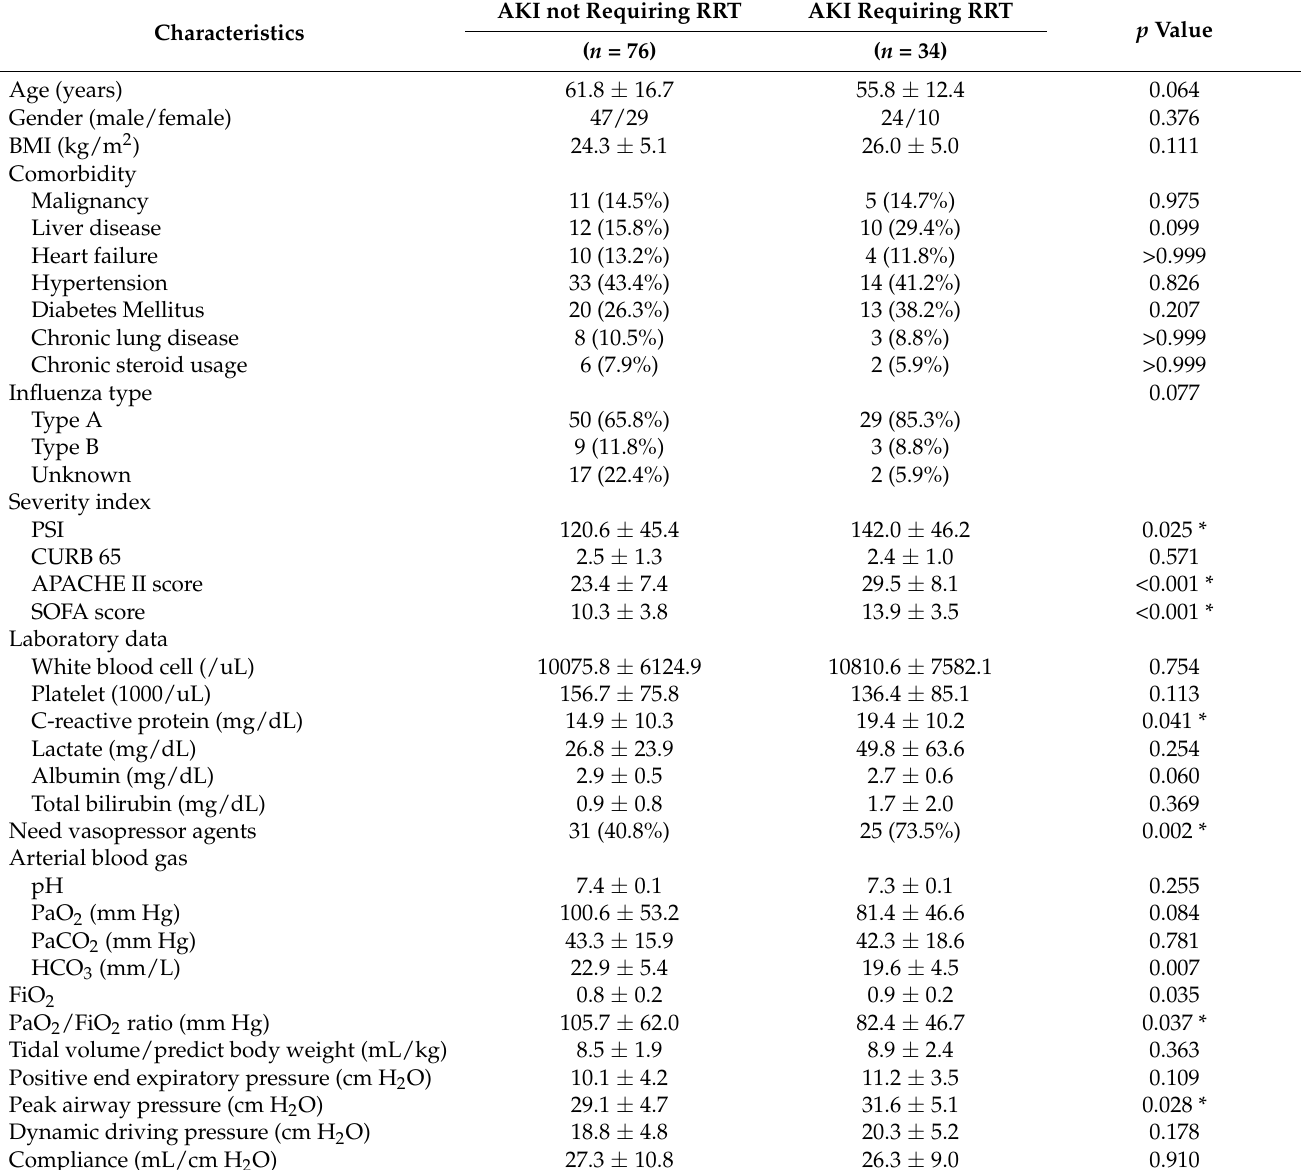
Table 2. Comparison of the AKI patients requiring RRT and not requiring